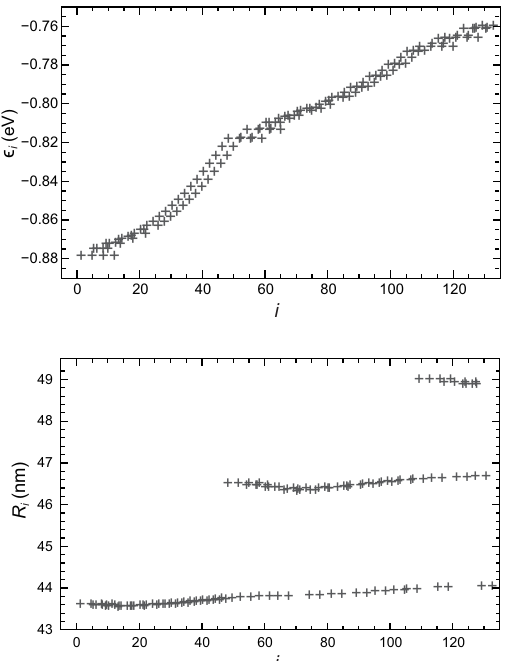
Figure 3. Top : First 130 eigenenergies (cid:101) i of the array with R = 40 nm and a = 200 nm vs. the solution number, i . The bias potential is V B = 1 V. The states are tightly packed in energy, forming a near continuous distribution. Bottom : Average radii R i of the electron-charge distribution in the same eigenstates, also vs. i . Three separate shells are visible, with R i ≈ 43.5 nm, 46.5 nm, and 49 nm, respectively. Notice the parabolic energy distribution in the different